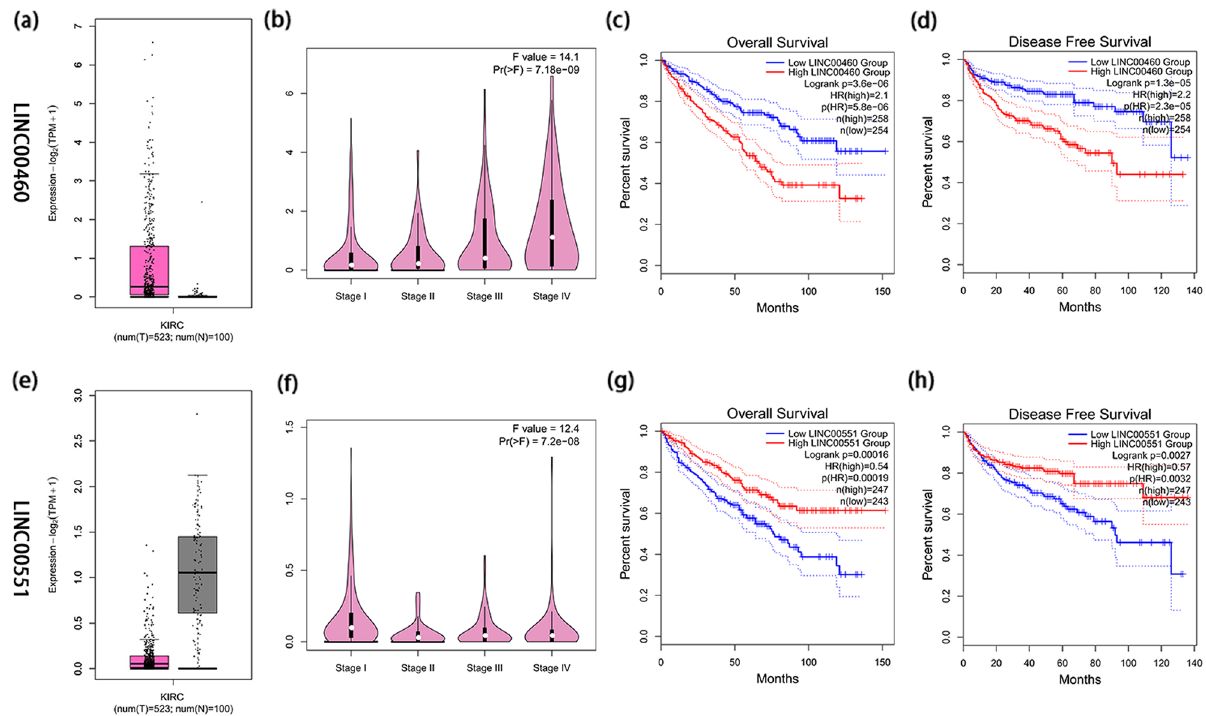
Figure 7. Confirmation of expression and prognosis of 2 FALs (LINC00460 and LINC00551) from the GEPIA2 database. ( a , e ) The expression of LINC00460 and LINC00561 in tumor and ccRCC tissues, respectively, the purple color represents ccRCC tissues while the grey color represents normal tissues. ( b , f ) LINC00460 expression enhanced with the development of stages (Pr = 7.18e−09), while, with the progression of stages, LINC00551 expression decreased (Pr = 7.2e−08). ( c , d , g , h ) The high expression level of LINC00460 and low expression of LINC00551 were all linked to a poor prognosis (all P <